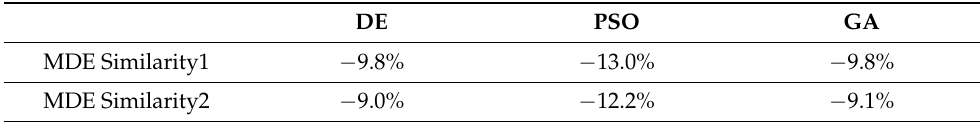
Table 8. The difference of assembly time for each